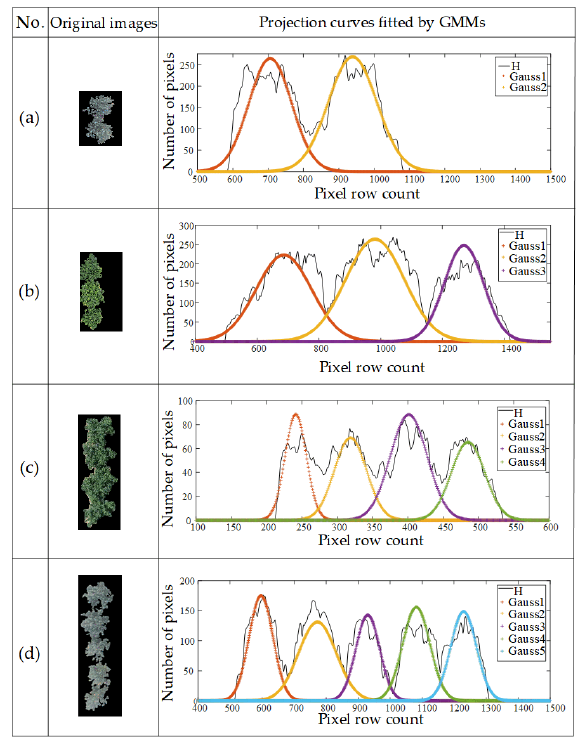
Figure 9. Examples of parameter solving: ( a ) two touching cherry trees; ( b ) three touching apple trees; ( c ) four touching cherry trees; ( d ) five touching apple trees. ( c ) four touching cherry trees; ( d ) five touching apple